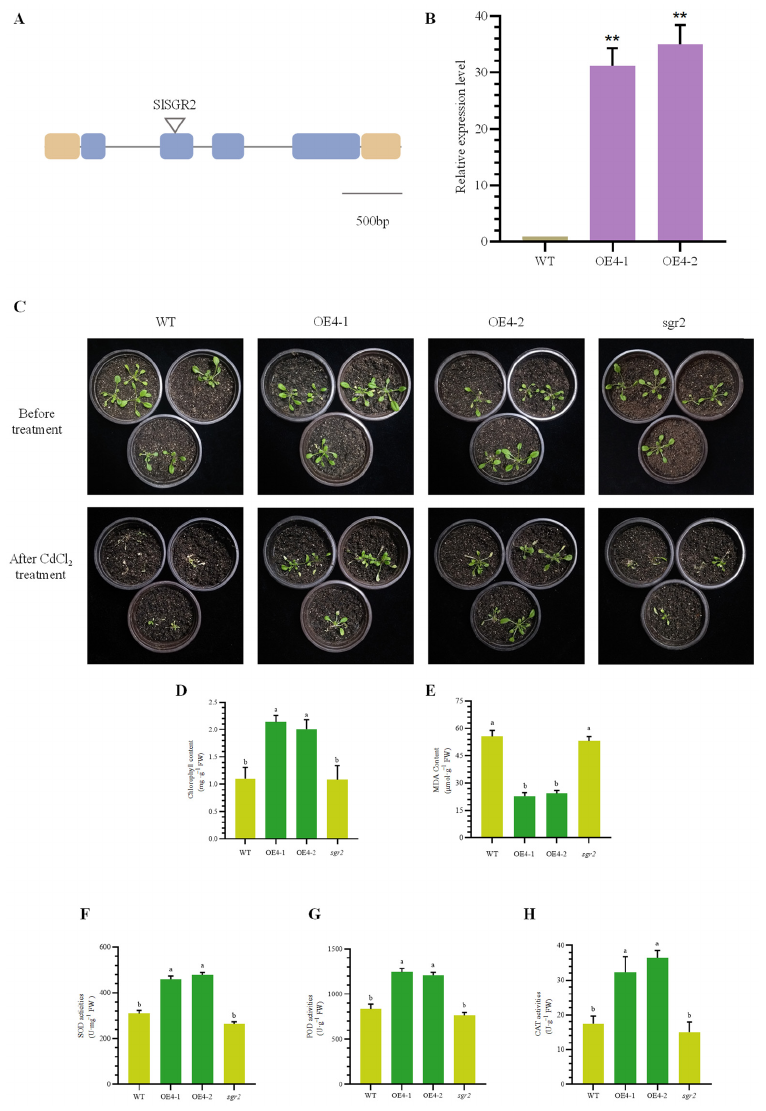
Figure 8. Phenotypic and physiological analysis of pCAMBIA2300- SlSGR2 transgenic lines under cadmium stress: ( A ) T-DNA insertion site; ( B ) expression level of SlSGR2 gene. Student’s t -test was performed; p < 0.05 was considered statistically significant (* <0.05 and ** <0.01); ( C ) six-week-old A. thaliana phenotype under 1 μ M cadmium stress for 14 days; ( D ) chlorophyll content of A. thaliana; ( E ) MDA content of A. thaliana ; ( F ) SOD activities of A. thaliana ; ( G ) POD activities of A. thaliana ; ( H ) CAT activities of A. thaliana. Lowercase letters indicate significant ( p < 0.05) differences among treatments according to Duncan’s test.